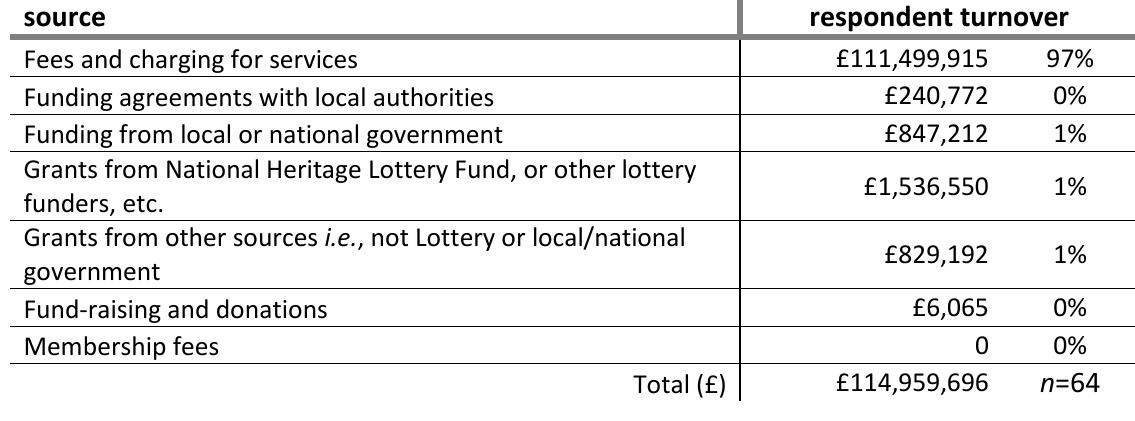
Table 14: Sources of turnover funding